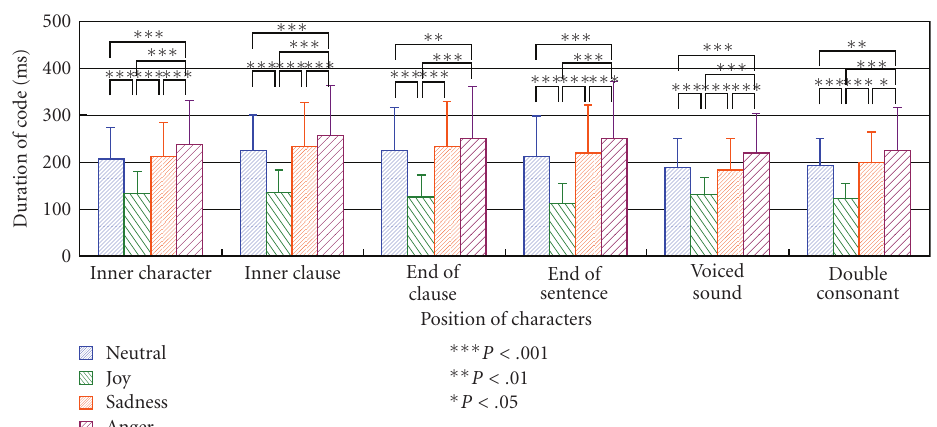
Figure 20: Mean of duration of code as a function of emotions and position of characters (error bars represent standard deviations).